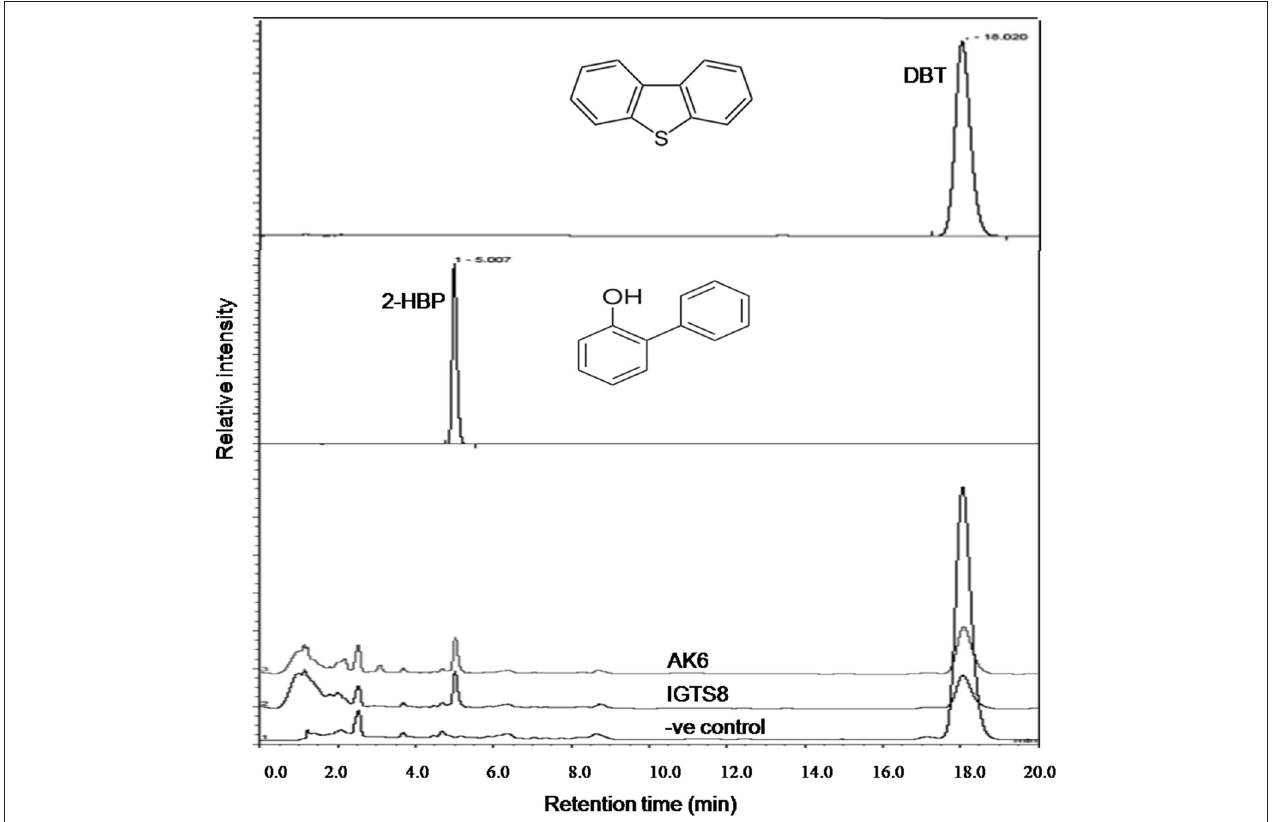
FIGURE 3 | HPLC chromatogram showing the biotransformation of DBT in resting cell assays for the AK6 mixed culture and the reference strain R. erythropolis IGTS8. The − ve control assay contained buffer and substrate only.